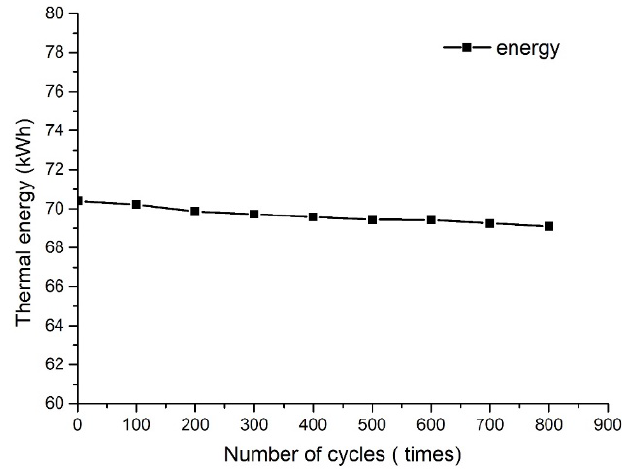
Figure 6. Discharging performance and heat storage efficiency during 800 cycles.